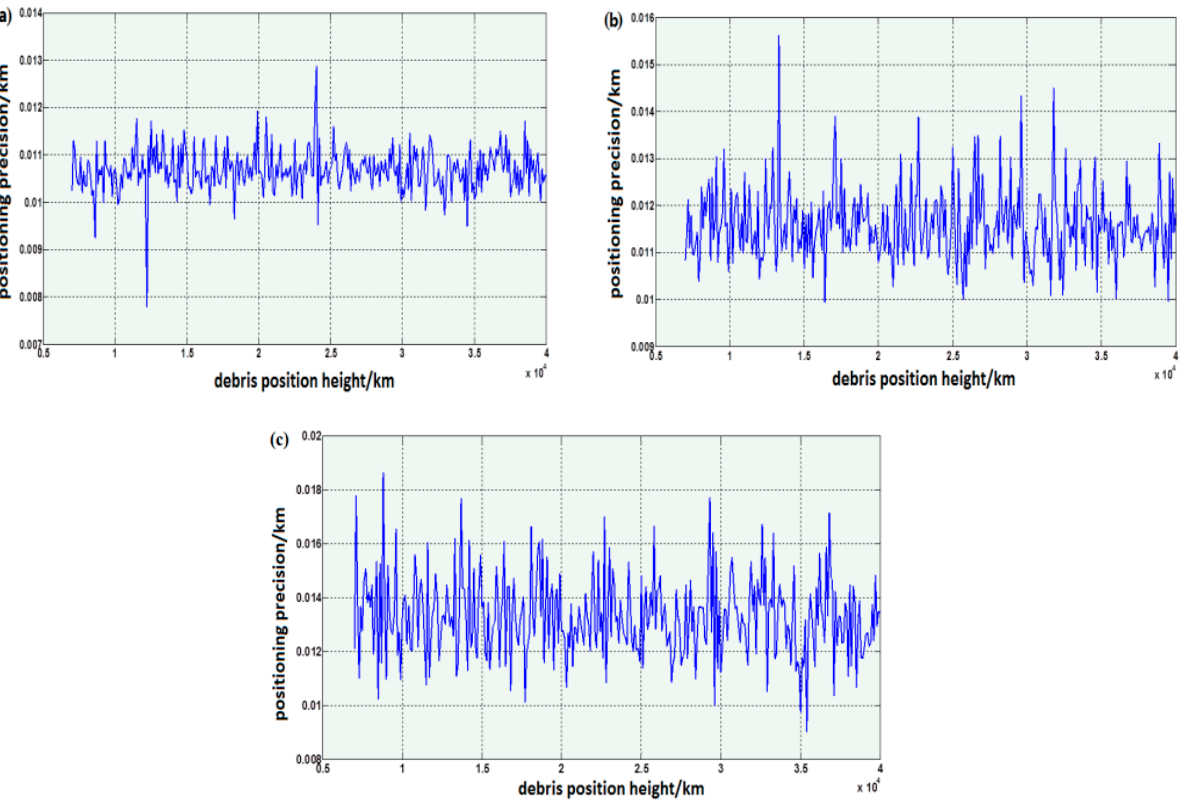
Figure 13. The positioning error of space debris varies with the height of the debris position at different observation distances when the star tracker’s own positioning error was 10 m. ( a ) The space debris observation distance of 50 km. ( b ) The space debris observation distance of 100 km. ( c ) The space debris observation distance of 200 km.